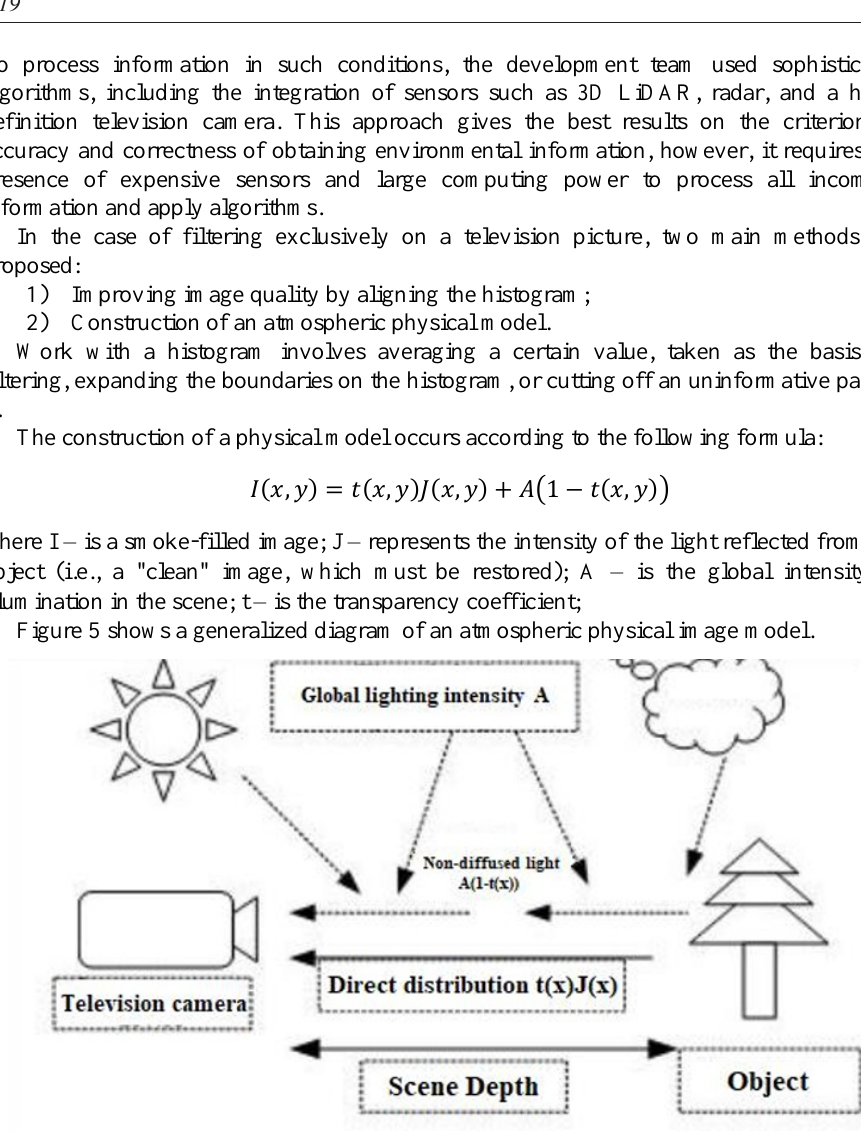
Fig. 5. A generalized diagram of the atmospheric physical image